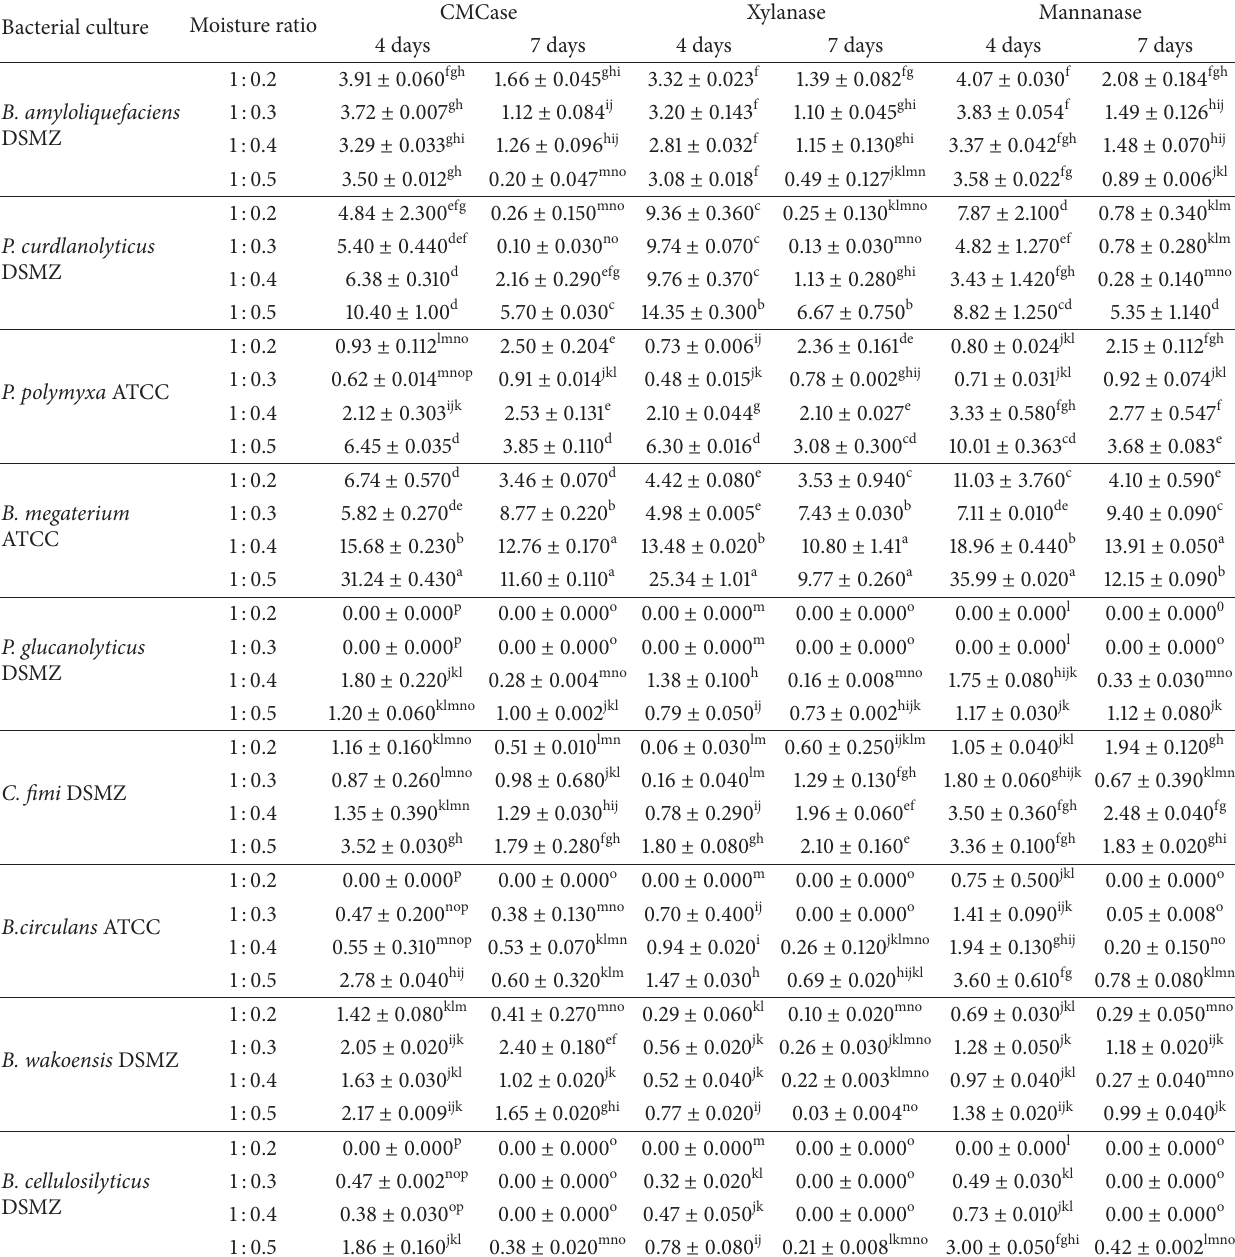
Table 1: Production of cellulolytic enzymes from bacterial cultures under SSF for 4 and 7 days with different PKC:moisture ratios. Bacterial culture